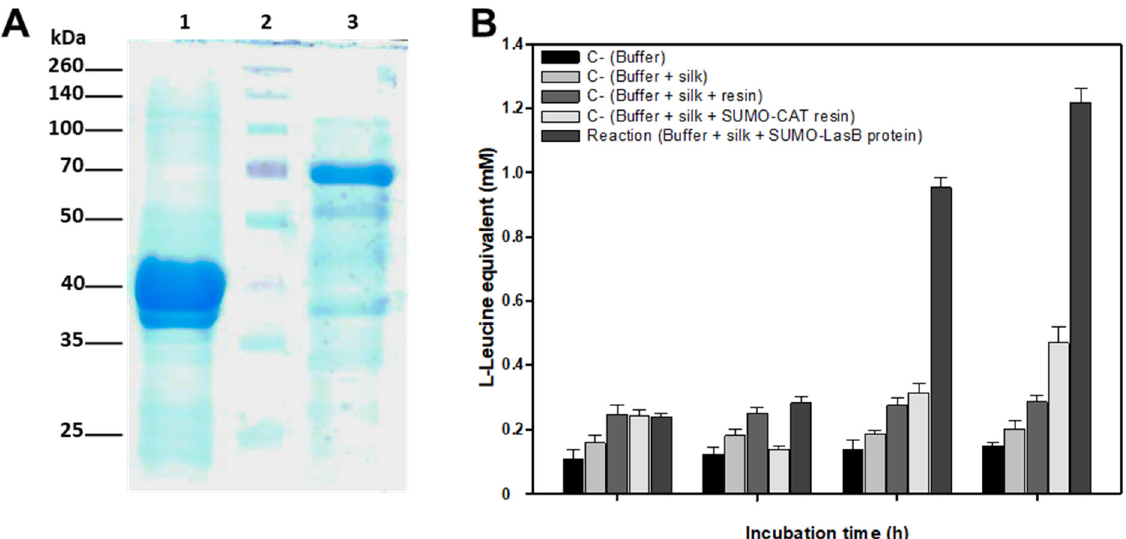
Figure 6. ( A ) Expression in E. coli and purification of SUMO-LasB recombinant protein by Ni- NTA affinity chromatography. Lanes: recombinant SUMO-CAT protein bound to Ni-NTA resin (1); Spectra multicolor Broad Range Protein Ladder (Thermo Fisher Scientific, Waltham, MA, USA) (2); recombinant SUMO-LasB protein bound to Ni-NTA after refolding (3). ( B ) Raw silk